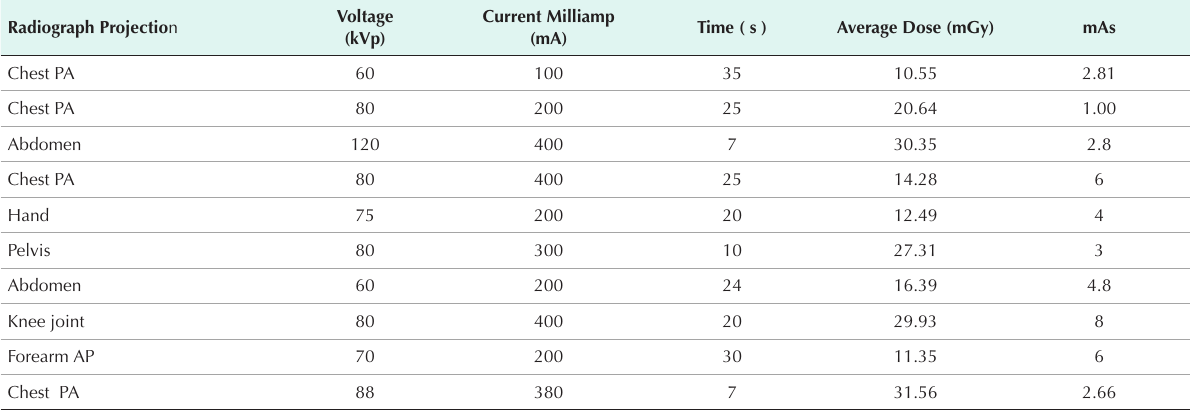
Table 1. The Technical Parameters of X-ray Tube for Age Group of 10-40 Years Radiograph Projectio